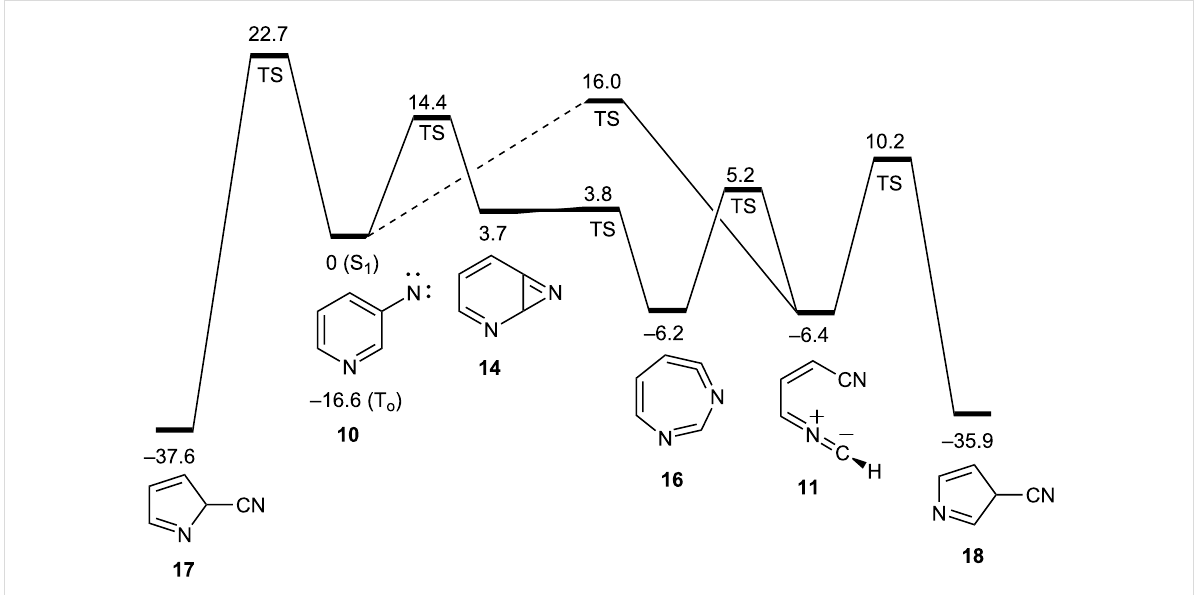
Figure 1: Energy profile for the ring opening and ring contraction in 3-pyridylnitrene 10 and 1,6-diazacyclohepta-1,2,4,6-tetraene ( 16 , energies in kcal/ mol at the B3LYP/6-31G* level).